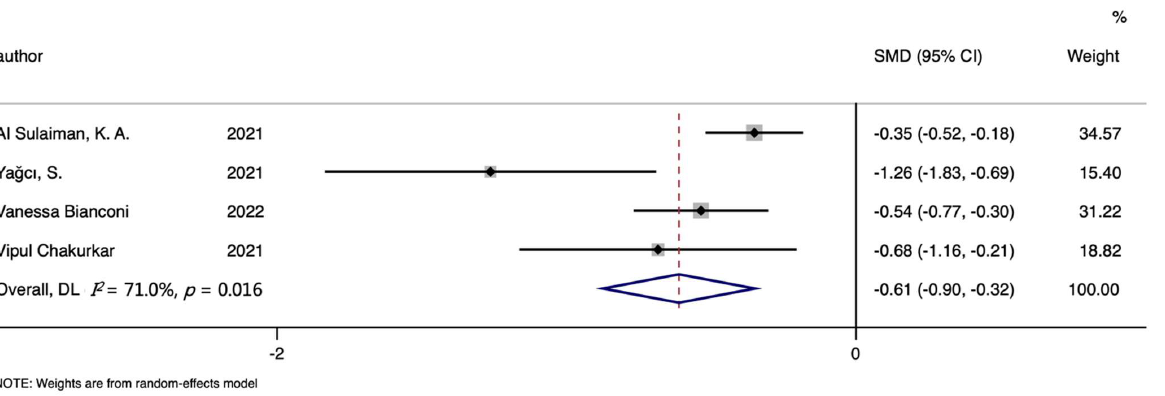
Figure 10. Forest plot of standard mean difference (SMD) with corresponding 95% confidence intervals (CIs) of studies [8,10,12,13] on TIBC levels in non-survivors and survivors. The solid diamond and horizontal line represent the study-specific effect and 95%CI, respectively; the size of the grey square is positively correlated with the weight distributed to each study in the meta-analysis. The center of open diamond with the vertical dashed line expresses the pooled SMD, and the width expresses the pooled